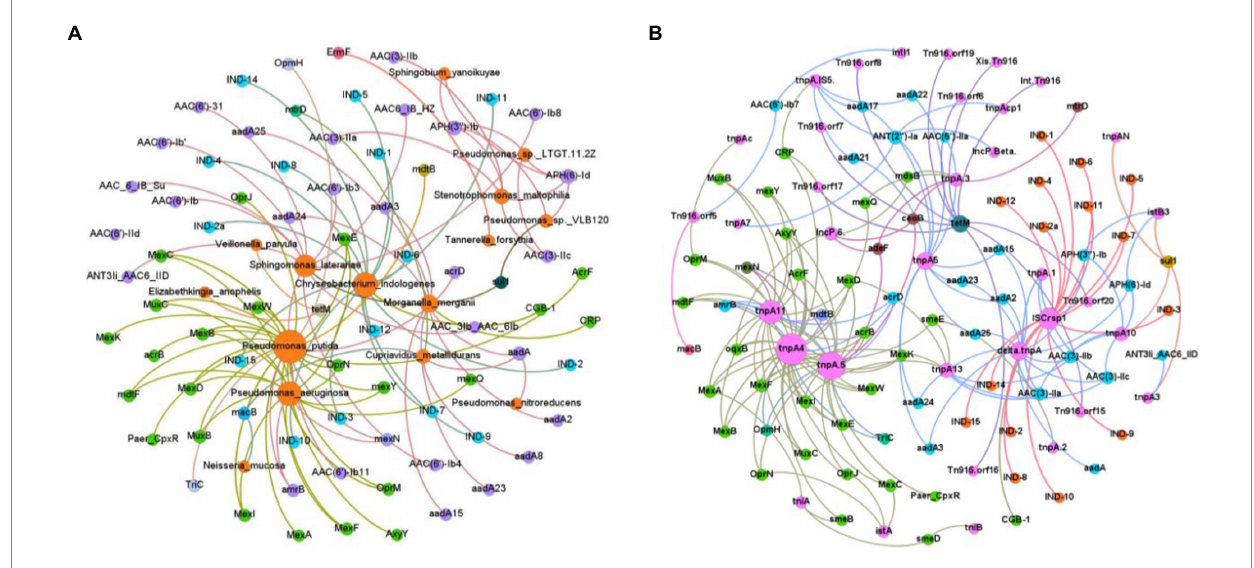
FIGURE 6 Network analysis of co-occurrence patterns. Each node connection indicates strong (Spearman correlation coefficient ρ > 0.8) and significant ( p < 0.01) correlation. The size of each node is proportional to the number of connections. (A) Co-occurrence network of bacteria and ARG. (B) Co-occurrence network of ARGs and